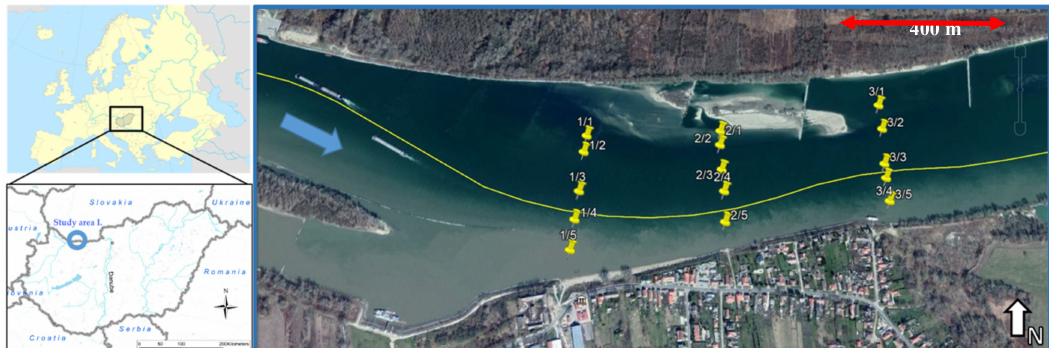
Figure 1. Study area I: Göny˝u, Hungary, River Danube (between rkm 1791.2 and rkm 1790.6). Sampling points are marked with yellow pins. Three cross-sections with 5–5 points were selected. Fixed boat measurements were carried out.